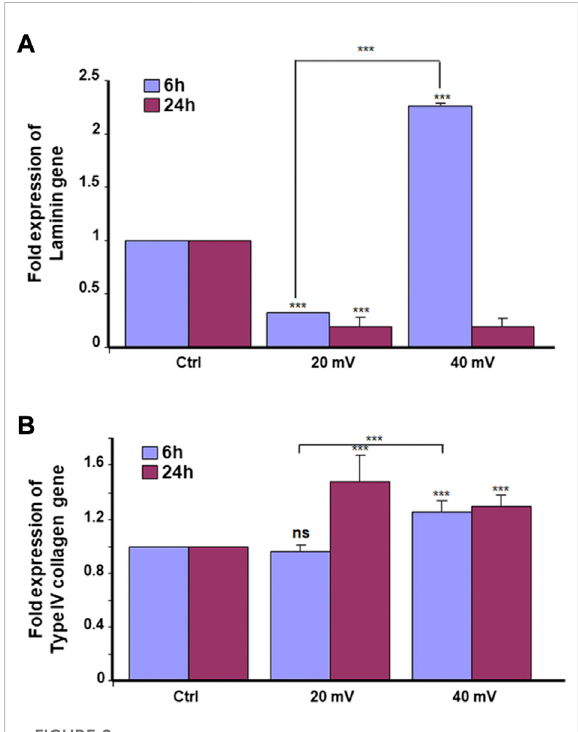
Laminin (A) and type IV collagen (B) expressions. The tissues were exposed for 6 and 24 h to ES. Total RNA was extracted from the tissues following each culture period and was subjected to quantitative RT-PCR of the laminin and Type IV collagen genes using speci fi c premiers. Results are presented as a fold expression of the gene in the test sample compared to this gene expression in control. Data are expressed as means ± SD from triplicate assays of three different experiments. (ns), non- signi fi cant. *** p ˂ 0.001. Free asterisks refer to the statistical difference when comparing the ES-exposed and nonexposed (Ctrl) tissues. Bars with asterisks show the comparison of the different intensities of